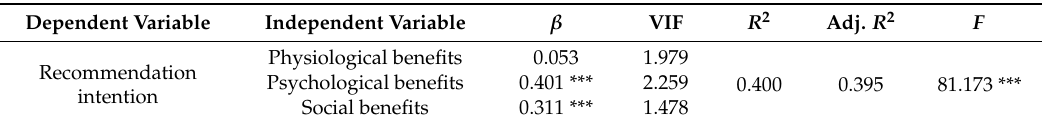
Table 7. Multiple regression analysis between subdimensions of leisure benefits and recommendation